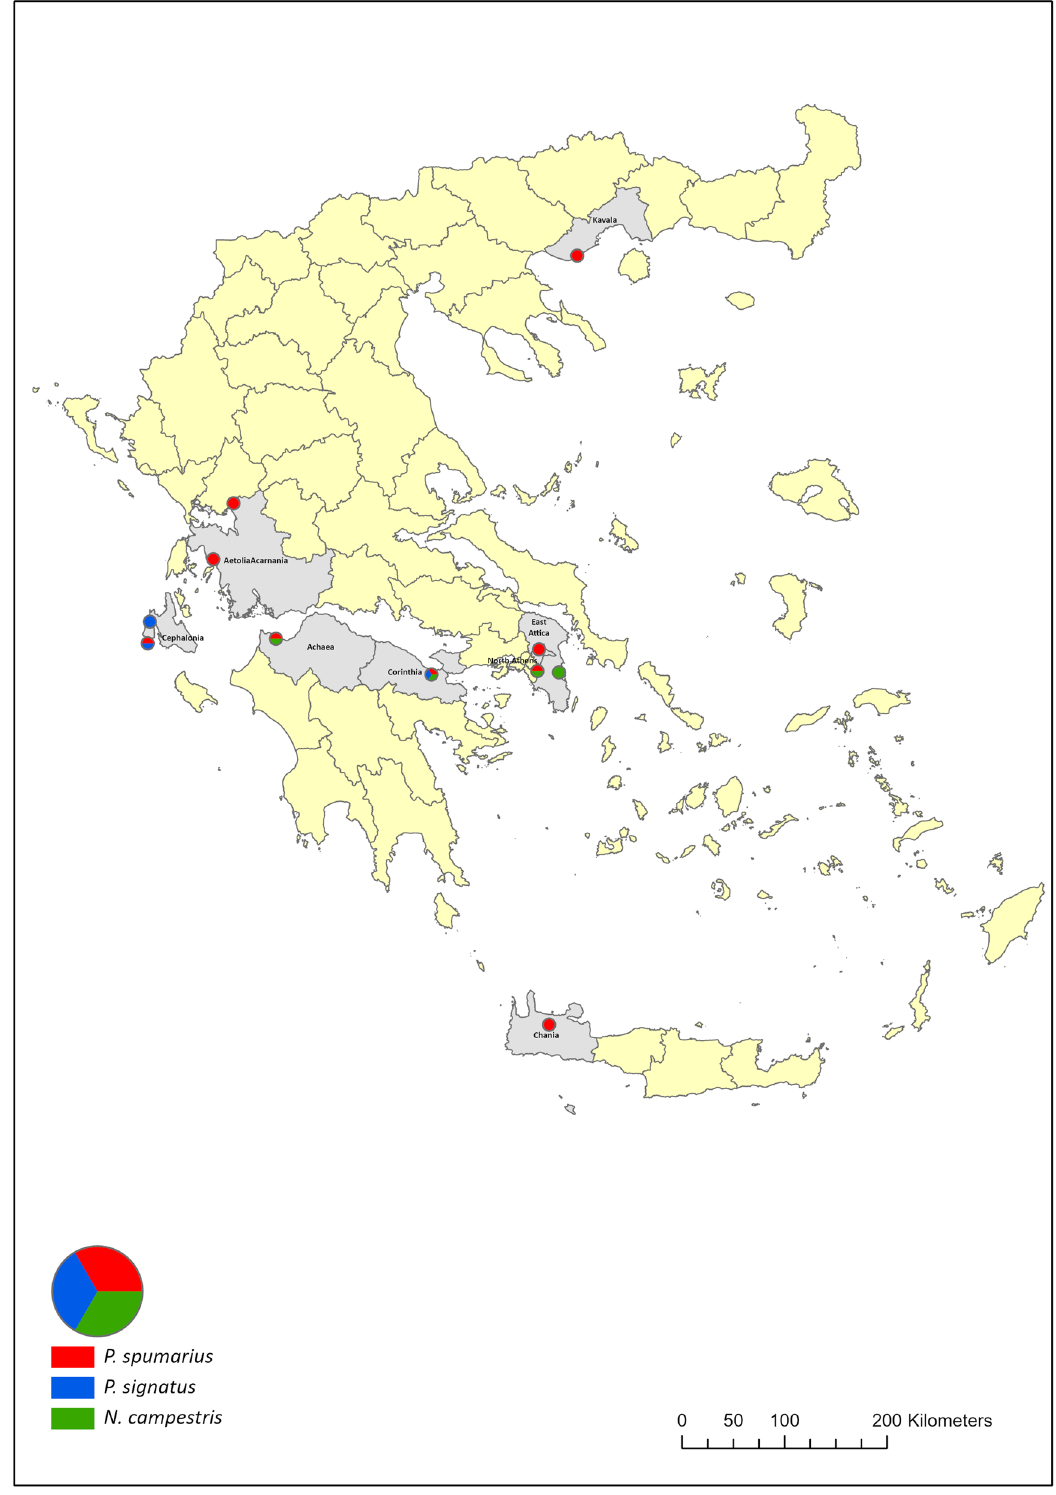
Figure 7. Collection sites of the analyzed populations of Philaenus spumarius , P. signatus and Neophilaenus campestris . The map has been generated with ArcGIS Pro v.2.5 software (https ://pro.arcgi s.com/en/pro-app/2.6/ get-start ed/what-s-new-in-arcgi s-pro-2-5.htm) (ESRI, RedLands, CA,